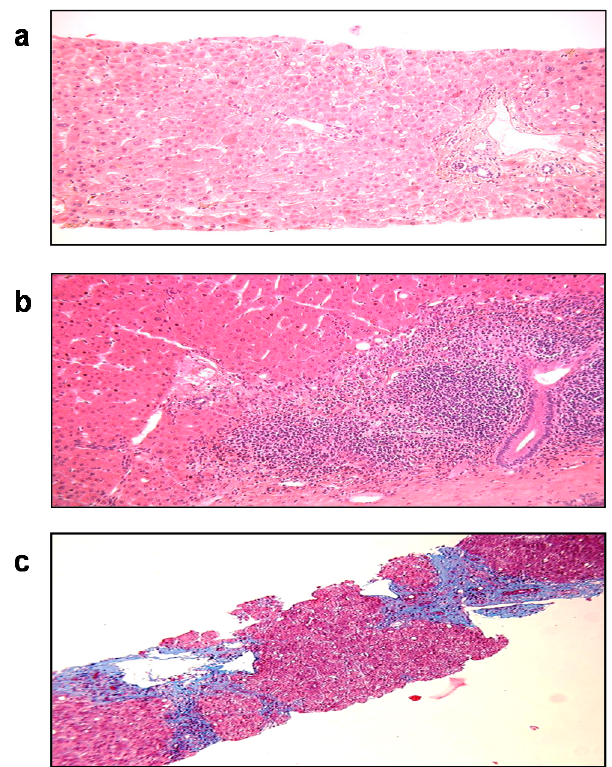
Figure 5. Histology of liver biopsies from a chronically HEV-infected patient. ( a ) Initial liver biopsy, ( b ) inflammation after 15 months of infection, and ( c ) Cirrhosis after 38 months of infection (Masson’s trichrome, magnification 100×).